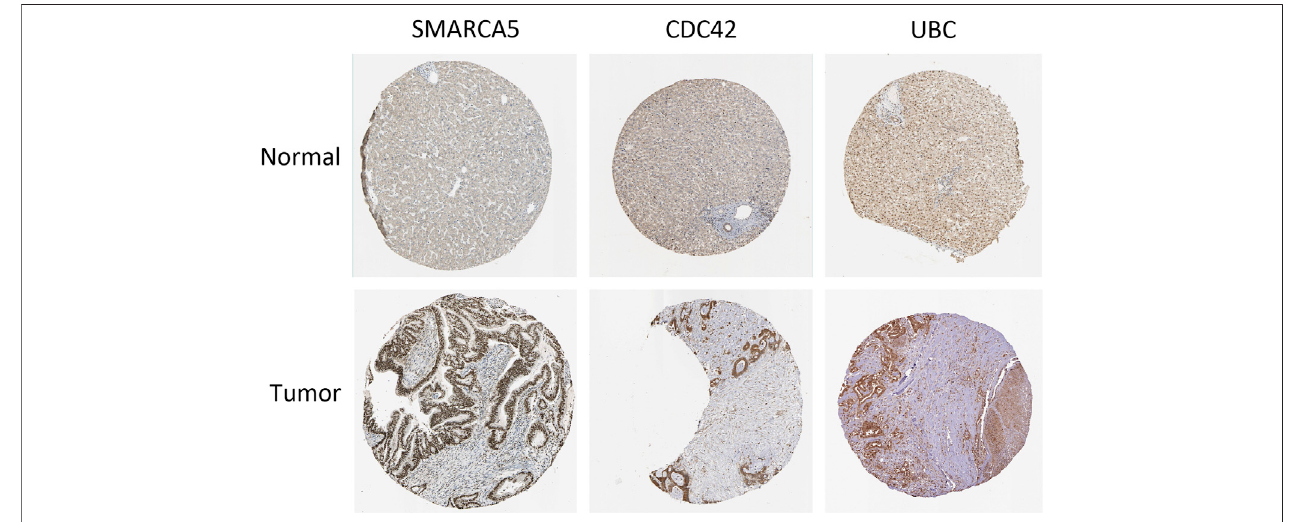
FIGURE 4 | Human Protein Atlas (HPA) online tool directly compares the protein expression of these three genes among normal and cancer tissues.